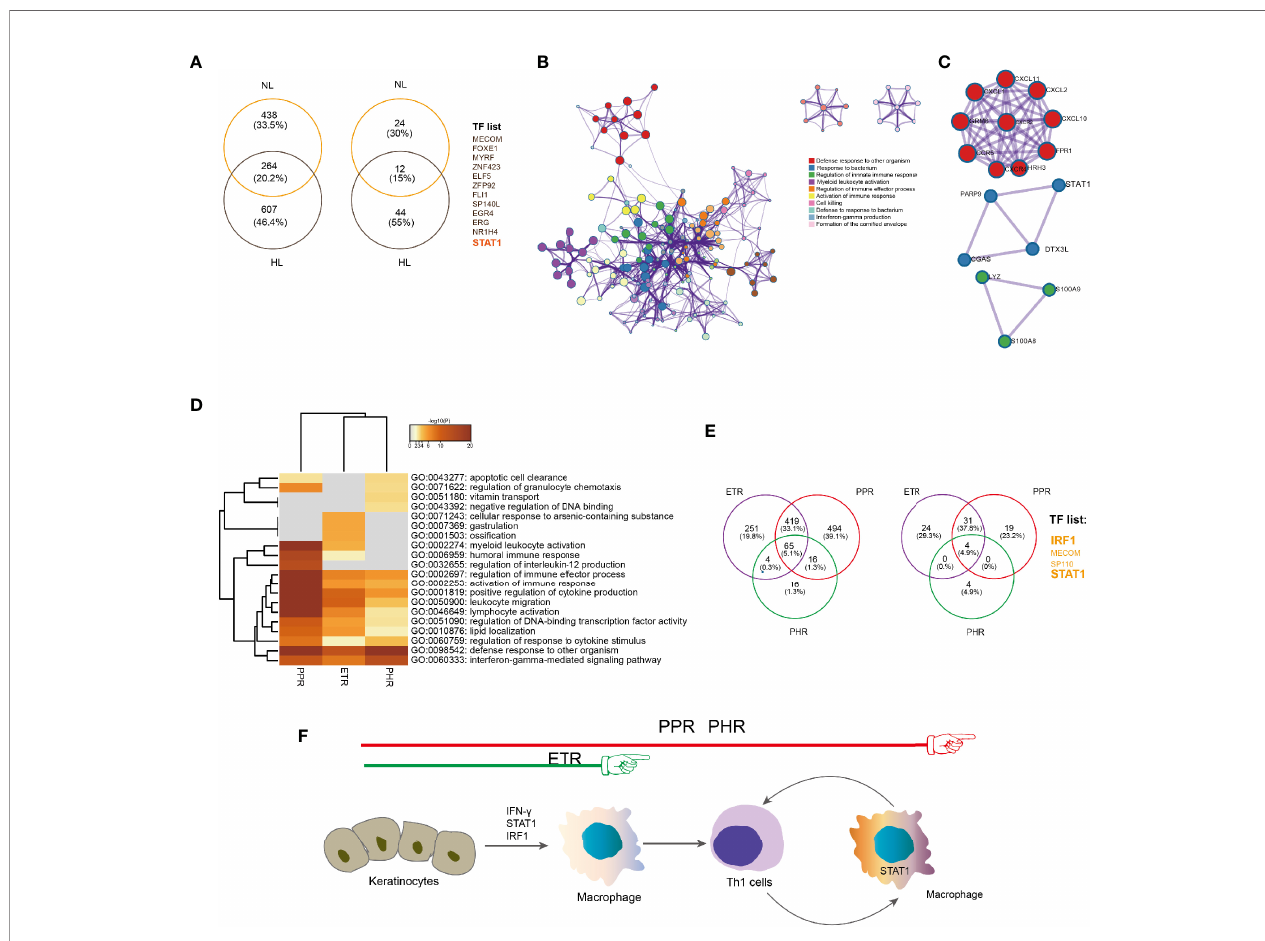
FIGURE 5 | Epidermal-derived IFN g /STAT1/IRF-1 signature in rosacea lesions. (A) Venn diagram showing the overlap between upregulated genes (left) and TFs (right) in rosacea lesions and matched normal skin surrounding the auricle (LS vs NS) and central facial skin from healthy controls (LS vs HS). HL: LS vs HS; NL: LS vs NS. (B) Metascape network analysis of the enrichment of the 264 shared upregulated genes related to the biological process IFN g production. (C) Protein – protein interaction constructed by the 264 shared genes indicate the STAT1 , PARP9 , DTX3L and CGAS interaction. (D) Metascape GO-term heatmap showing the IFN g signaling pathway shared across ETR, PPR and PHR subtypes. (E) Venn diagram showing the overlap between upregulated genes (left) and transcription factors (right) in ETR, PPR and PHR subtypes compared with central facial skin from healthy controls. (F) Proposed model for IFN g /STAT1/IRF-1 signature triggering activation of in fl ammatory responses in rosacea lesions. Hypothesized immune cells involved in rosacea from ETR to PPR and